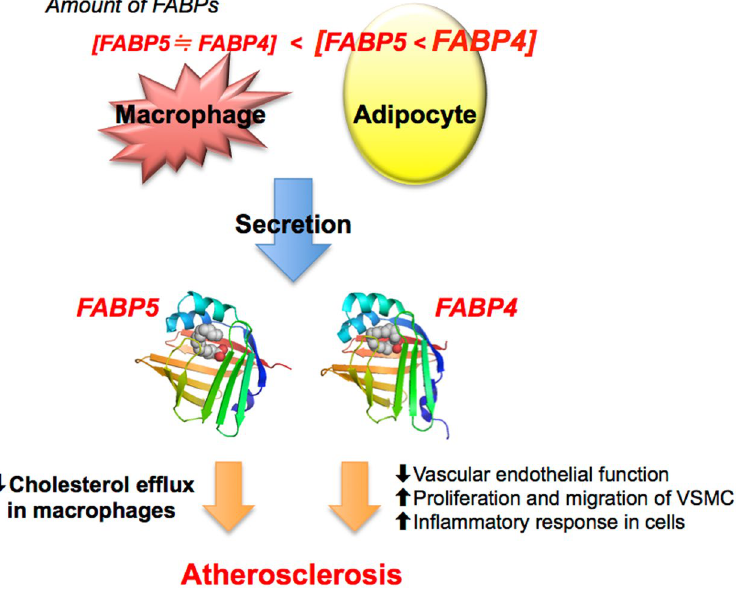
Figure 2. Putative mechanism of the development of atherosclerosis by secreted FABP4 and FABP5. The expression of FABP5 is about one-hundredth of that of FABP4 in adipose tissue, and the amount of FABP4 in adipocytes is about 10,000-fold larger than that in macrophages (ref. 11). The stoichiometry of FABP4 and that of FABP5 in macrophages are almost identical (ref. 15). Both FABP4 and FABP5 are secreted from adipocytes and macrophages (refs 21 – 23 and 39). Direct effects of exogenous FABP4 in various types of cells have been demonstrated. Treatment with recombinant FABP4 inhibited activation of endothelial nitric oxide synthase in vascular endothelial cells, increased proliferation/migration of vascular smooth muscle cells (VSMC) and induced inflammatory responses in macrophages, vascular endothelial cells and VSMC (ref. 23), leading to the development of atherosclerosis. In the present study, the level of FABP5, but not that of FABP4, was an independent negative predictor of cholesterol efflux capacity (CEC) as an HDL function, indicating that circulating FABP5 contributes to the development of atherosclerosis via reduction of CEC in macrophages. The mechanism of direct association between CEC and FABP5 level needs to be addressed in experimental